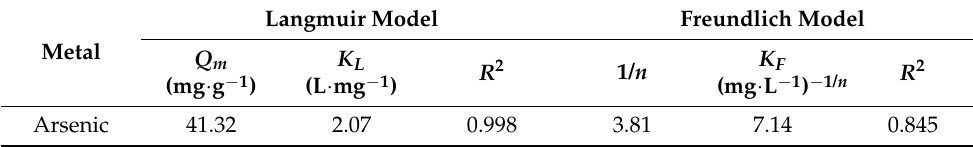
Table 3. Parameters of isotherm arsenic ions on the adsorbent.